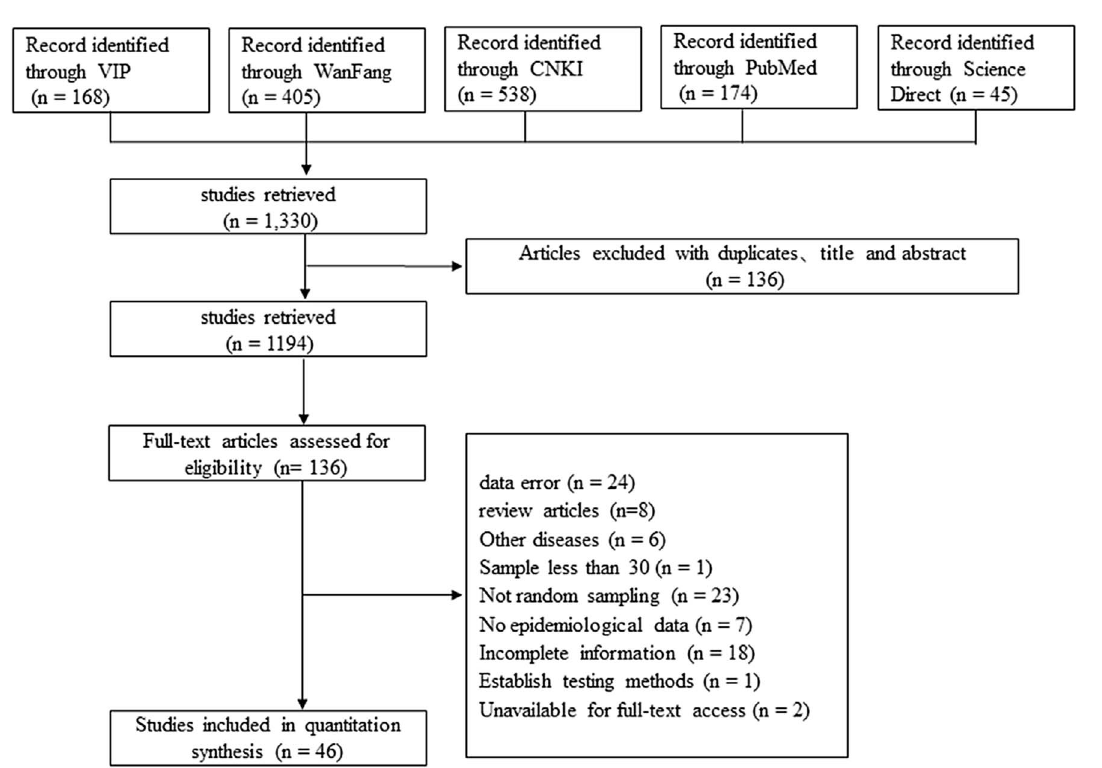
Figure 1. Screening process for eligible